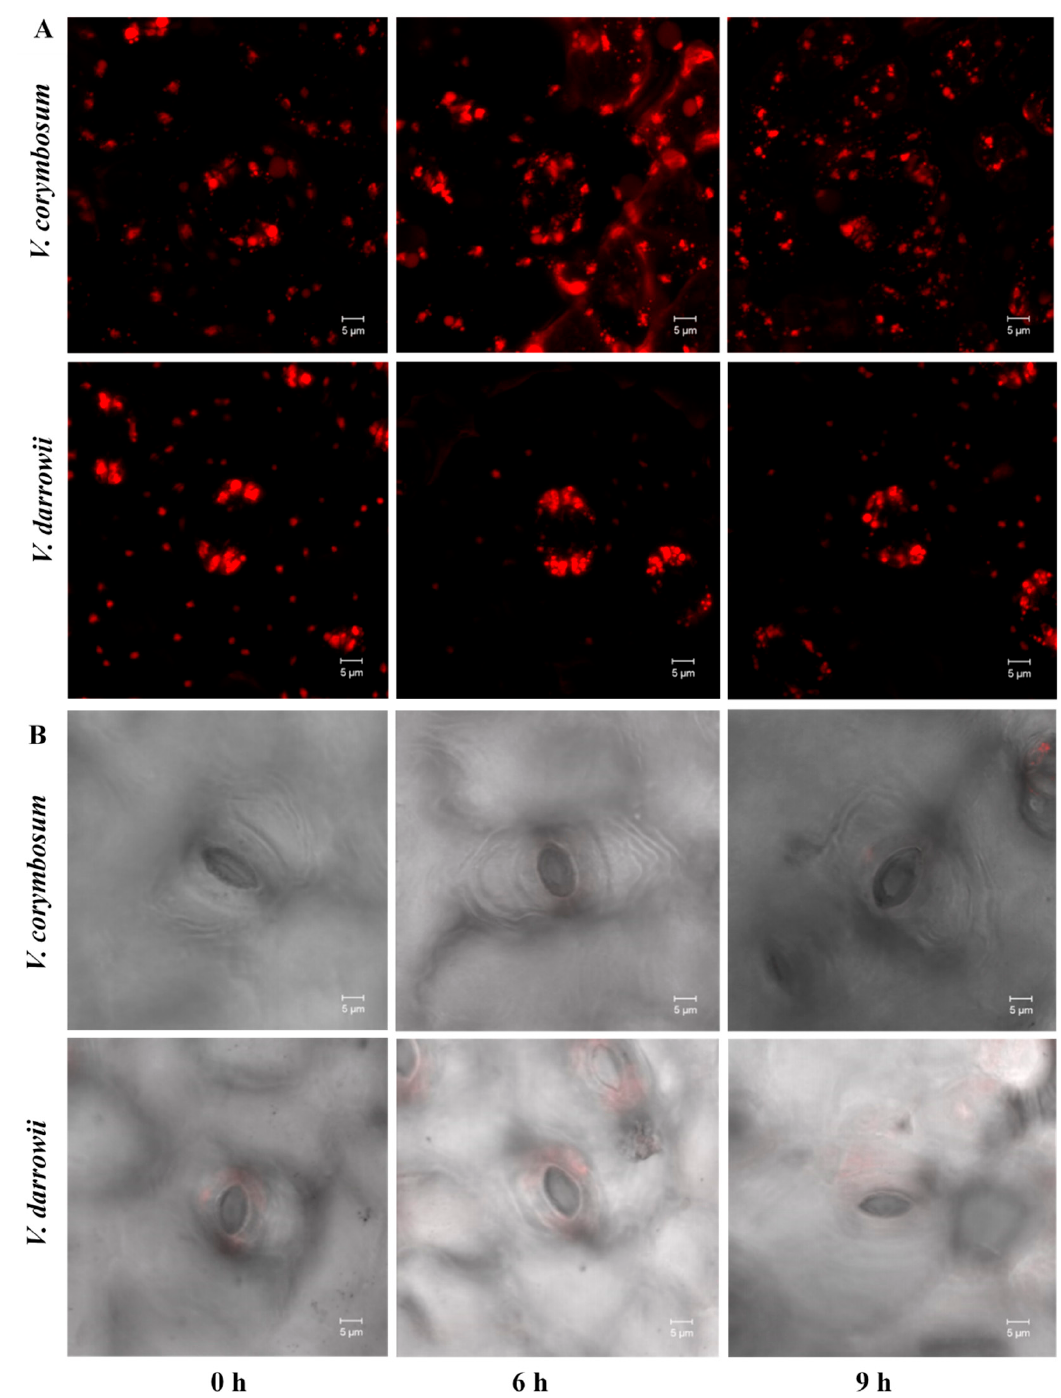
Figure 1. Laser scanning confocal microscopy (LSCM) imaging of stomata internal organelles and cell surface features of two blueberry species. ( A ) Stomata internal organelle surface area at different heat stress imposition periods (0, 6, and 9-h heat stress): Maximum projection of z stack with staining shows the wide opened structure of stoma organelle surface area that exhibits an intense red signal in V. darrowii compared to V. corymbosum . ( B ) LSCM micrographs showing the surface structure of stomata cell opening (guard cells).